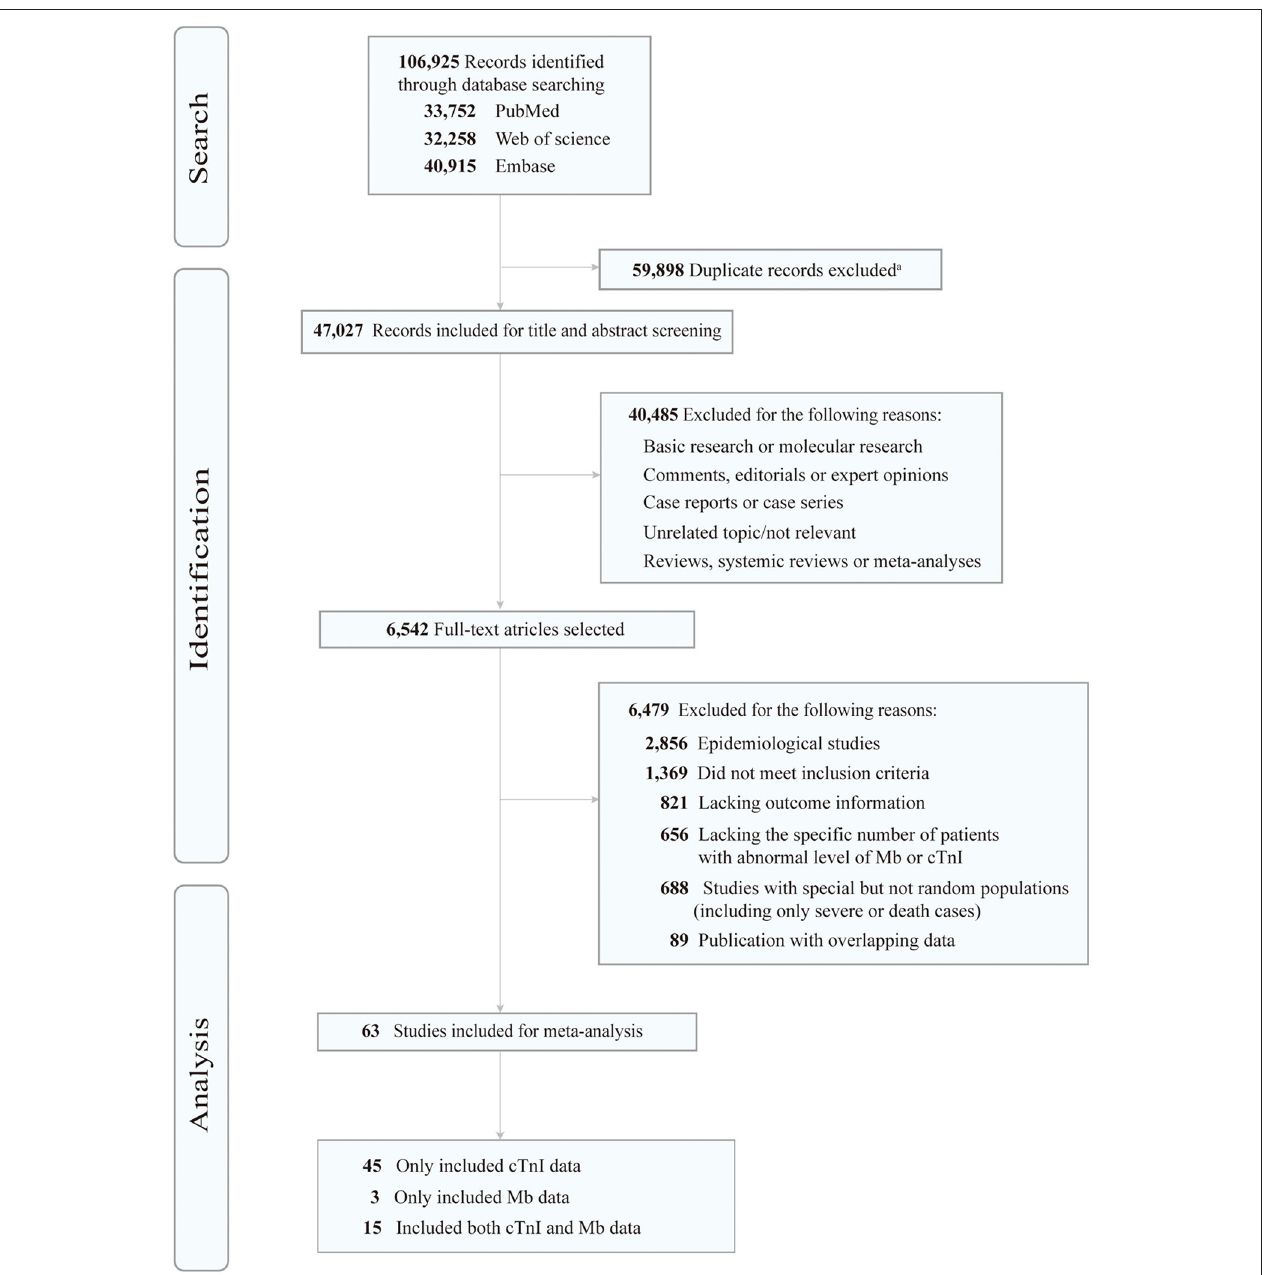
FIGURE 1 | Flow chart of the study selection process. Mb, myoglobin; cTnI, cardiac troponin I. a EndNote software (Clarivate Analytics) was used to remove